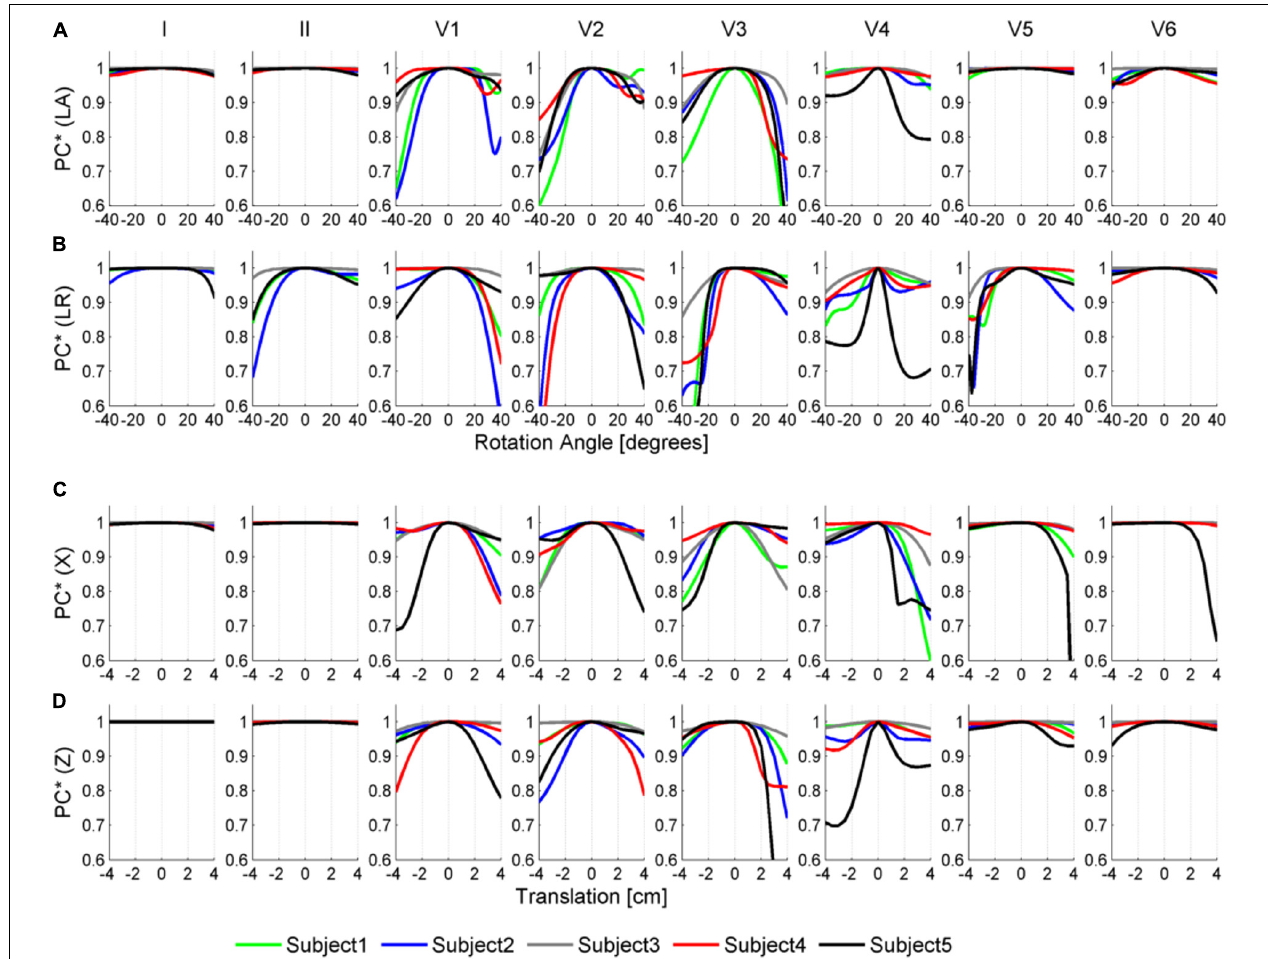
FIGURE 7 | Similarity measurement (PC ∗ ) for each lead (I, II, V1–V6) between the QRS at the original pose and the QRS when the heart is rotated along the long axis (LA) in panel (A) , the left-to-right-ventricles axis (LR) in panel (B) , and when translated in the lateral and cranio-caudal directions in panels (C,D) , respectively. Rotation angles range from –40 ◦ to 40 ◦ and translations range from –4 to 4